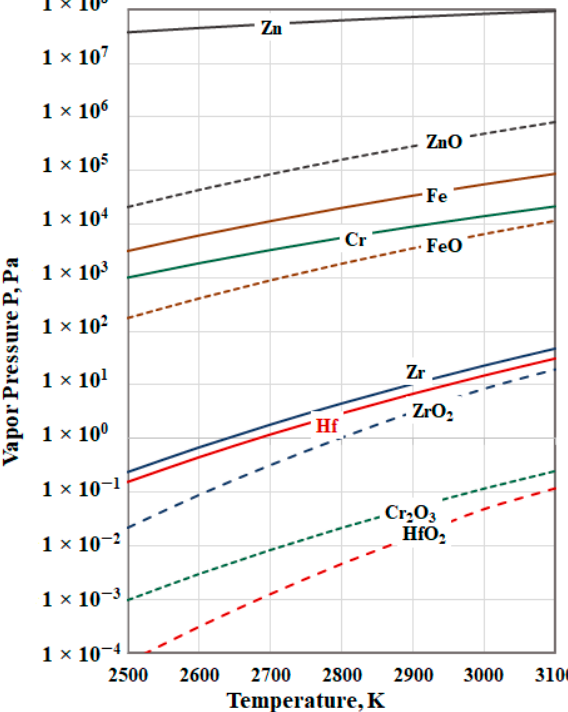
Figure 2. The vapor pressure of hafnium, metal impurities, and their oxides.